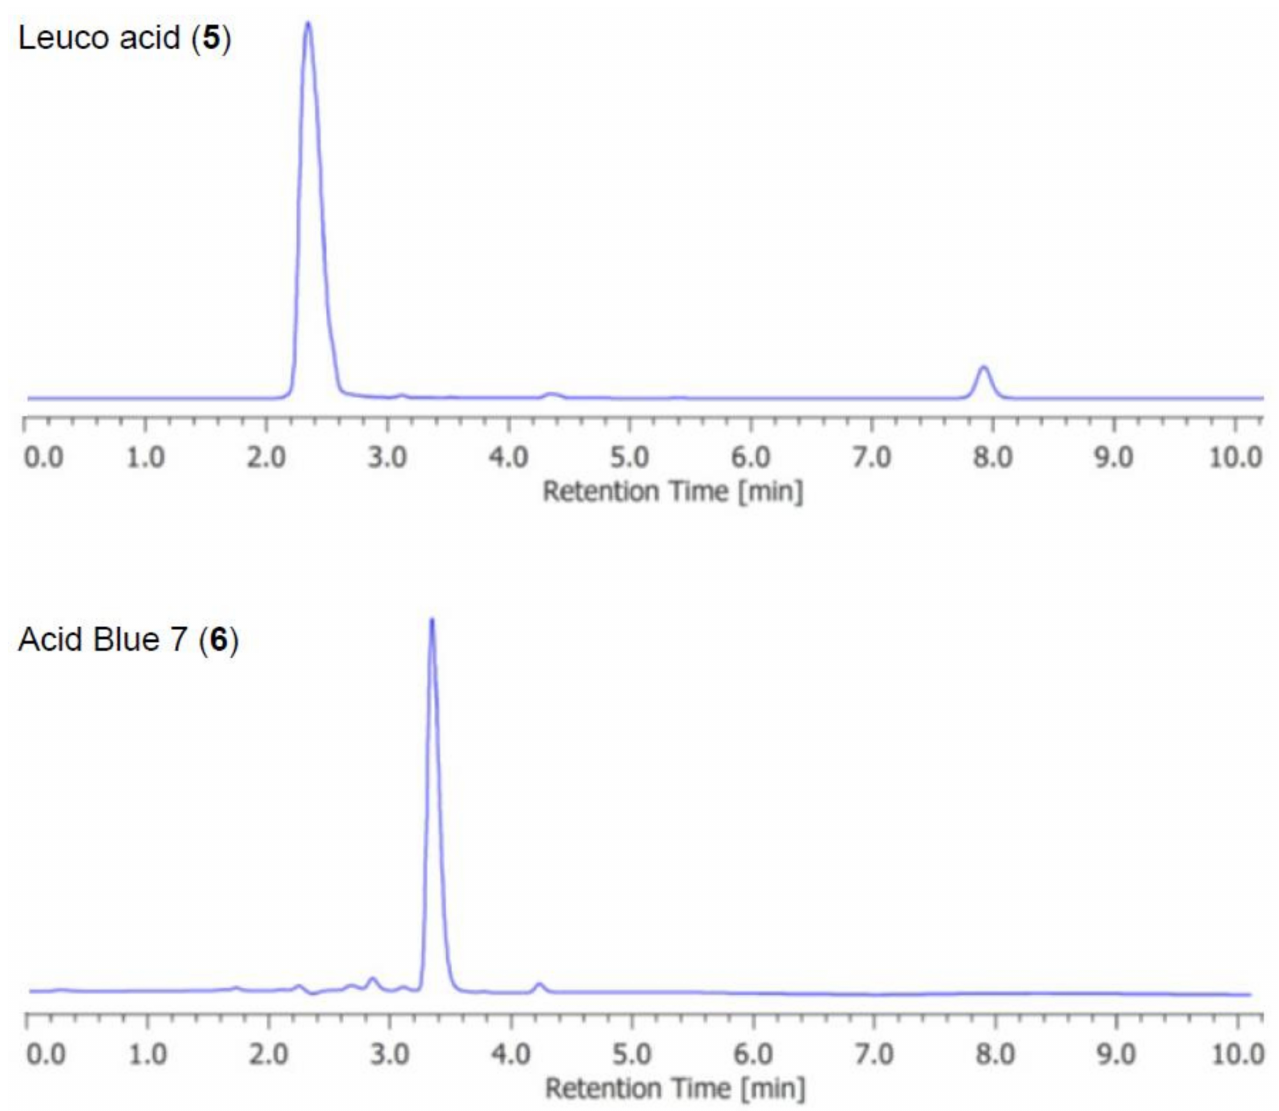
Figure 2. HPLC charts for leuco acid ( top ) and Acid Blue 7 ( bottom ) ( λ = 254 nm, CH 3 CN:0.05% H 3 PO 4 aq. =